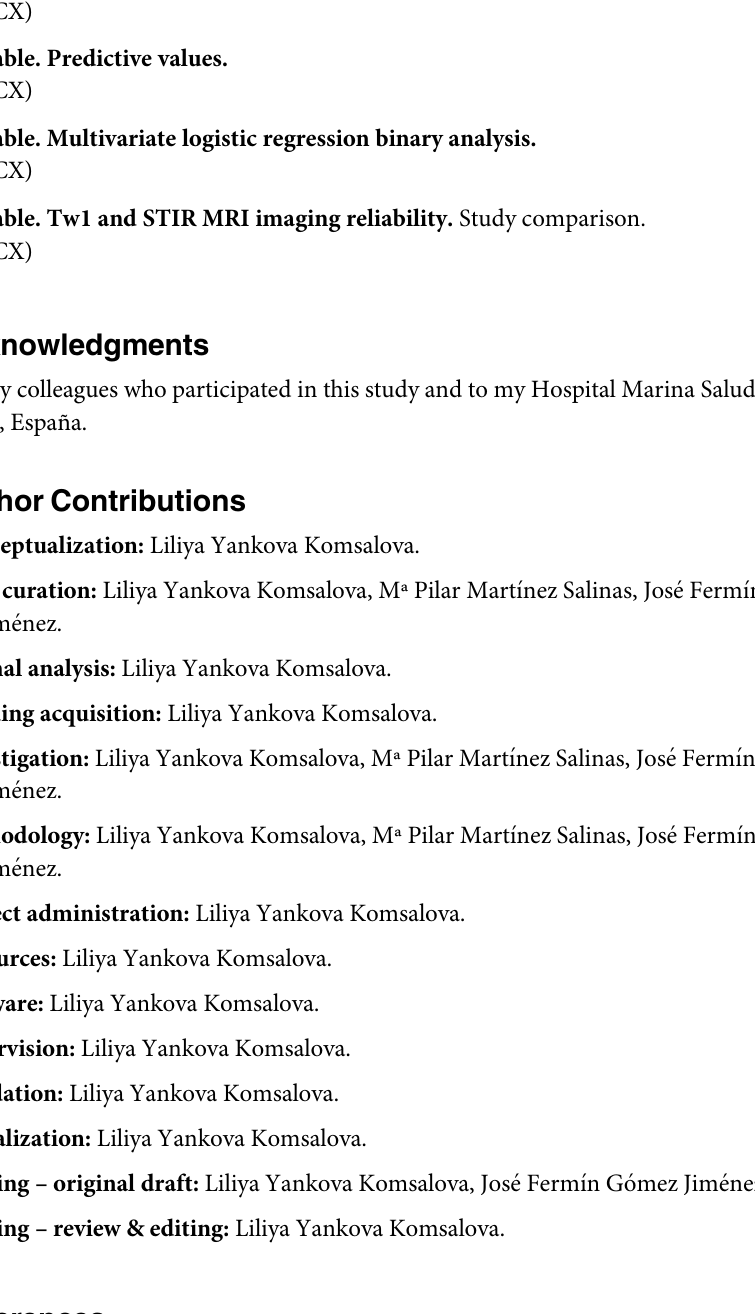
S2 Table. Statistical analysis. S3 Table. Predictive values. S4 Table. Multivariate logistic regression binary analysis. S5 Table. Tw1 and STIR MRI imaging reliability. Study